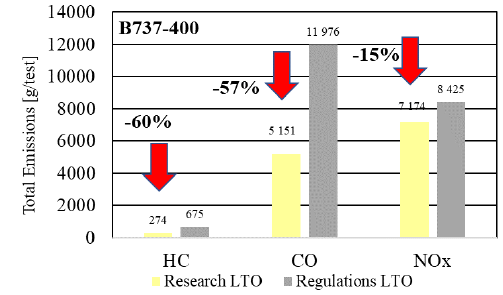
Fig. 11. Total emission of toxic exhaust fumes for adopted and regulations LTO for B737-400